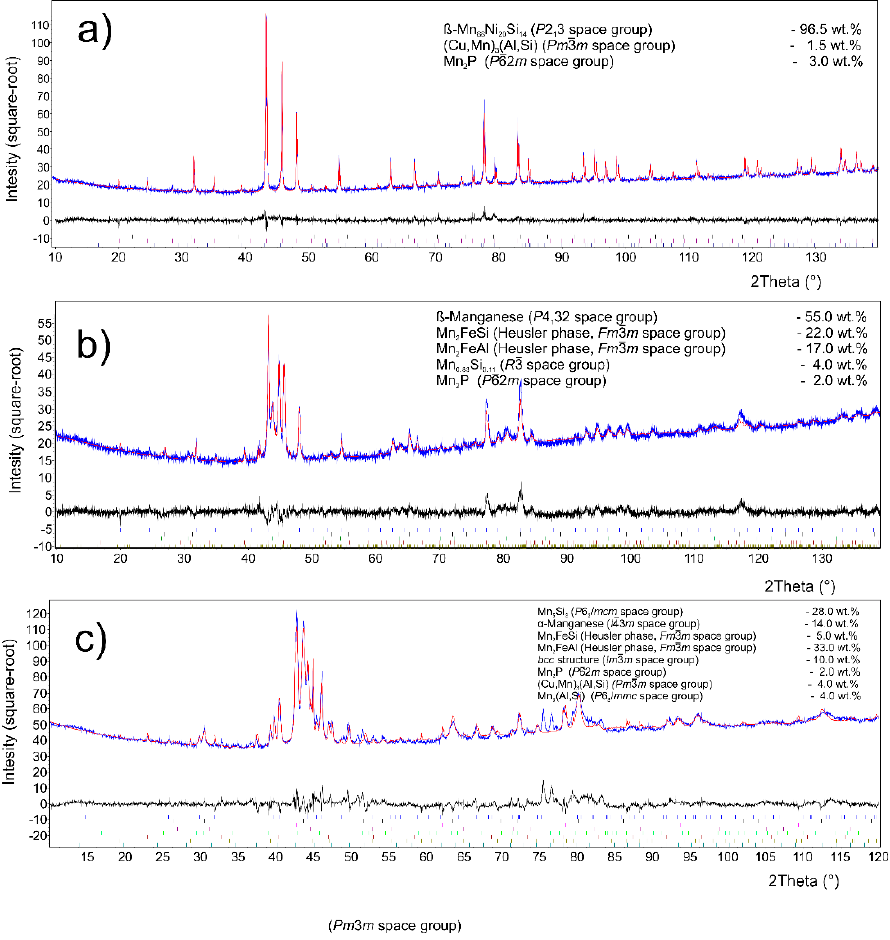
Figure 2. Phase composition by XRD for sample ( a ) with stoichiometric amount of aluminum; ( b ) with 10% of aluminum excess; and ( c ) with 20% of aluminum excess. The blue color indicates the measured XRD patterns, while the red color is the Rietveld fit, the black color shows the difference between the real pattern and the numerical fit. Table 3. Composition in at. % of phases in sample with stoichiometric amount of aluminum measured by EDS. Measured compositions from areas investigated by EBSD are given. Error of measurement depends on number of counts in peak. The elements typical for minor phases are given in